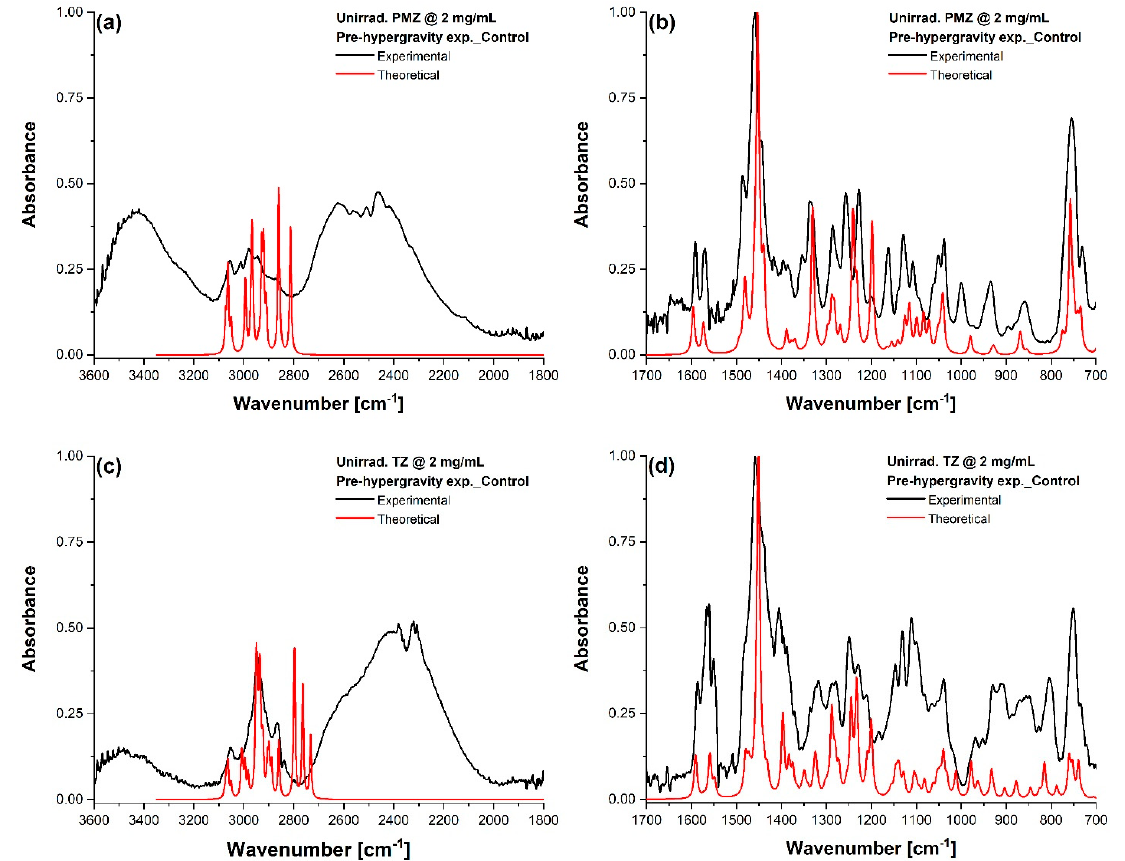
Figure 4. Experimental and theoretical FTIR spectra of unirradiated phenothiazine solutions. Unirradiated PMZ at 2 mg/mL in the range ( a ) 3600–1800 cm − 1 and ( b ) 1700–700 cm − 1 . Unirradiated TZ at 2 mg/mL in the range ( c ) 3600–1800 cm − 1 and ( d ) 1700–700 cm − 1 .